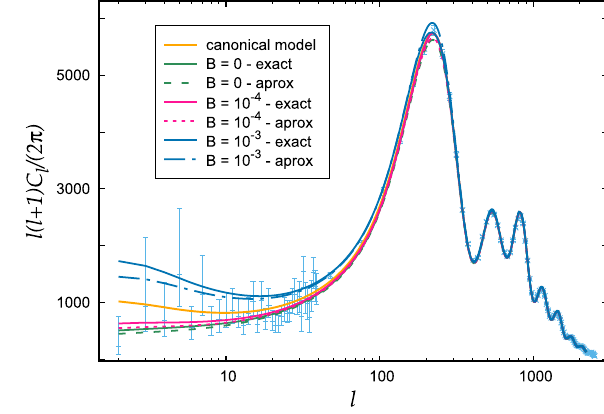
Fig. 2 Angular power spectrum of the temperature anisotropy auto- correlation function. The canonical model is represented in orange. The solidanddashedlinescorrespondtotheexactandapproximatedexpres- sions for the PPS obtained from the CSL model, respectively. Here we considered a 0 H 0 = 2 × 10 − 4 , and three values for B = 0 , 10 − 4 , 10 − 3 . The plot depicts the behaviour of our model’s predictions, progres- sively separating from the original model ( B = 0 ) and approaching to the canonical model either from above or below. The effect is mainly observed at the lowest multipoles, while larger multipoles are unaf- fected. Planck’s data and error bars are shown in order to provide some intuition of the effects the model might bring in when fitting observa- tional